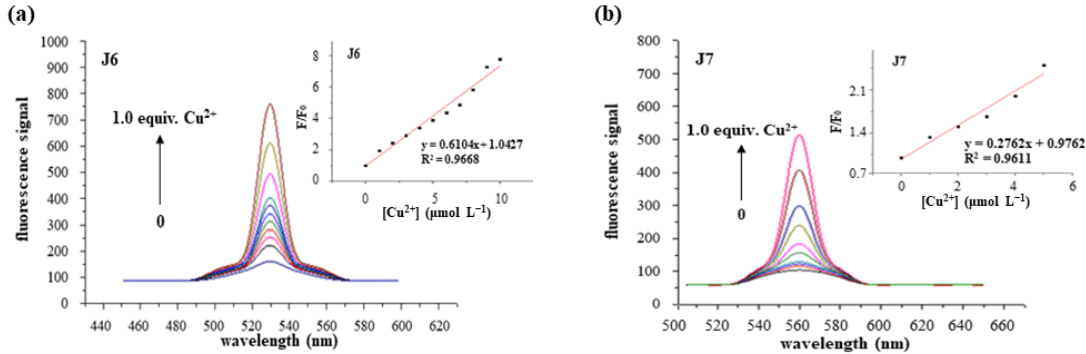
Figure 5. Fluorescence titration curve of ( a ) J6 and ( b ) J7 with Cu 2+ (J6: 10 µ mol L − 1 , J7: 10 µ mol L − 1 ). constant K a as 3.62 × 10 6 L mol −1 , also demonstrating 1:1 association stoichiometry between J7 and Cu 2+ (Figure 6b).